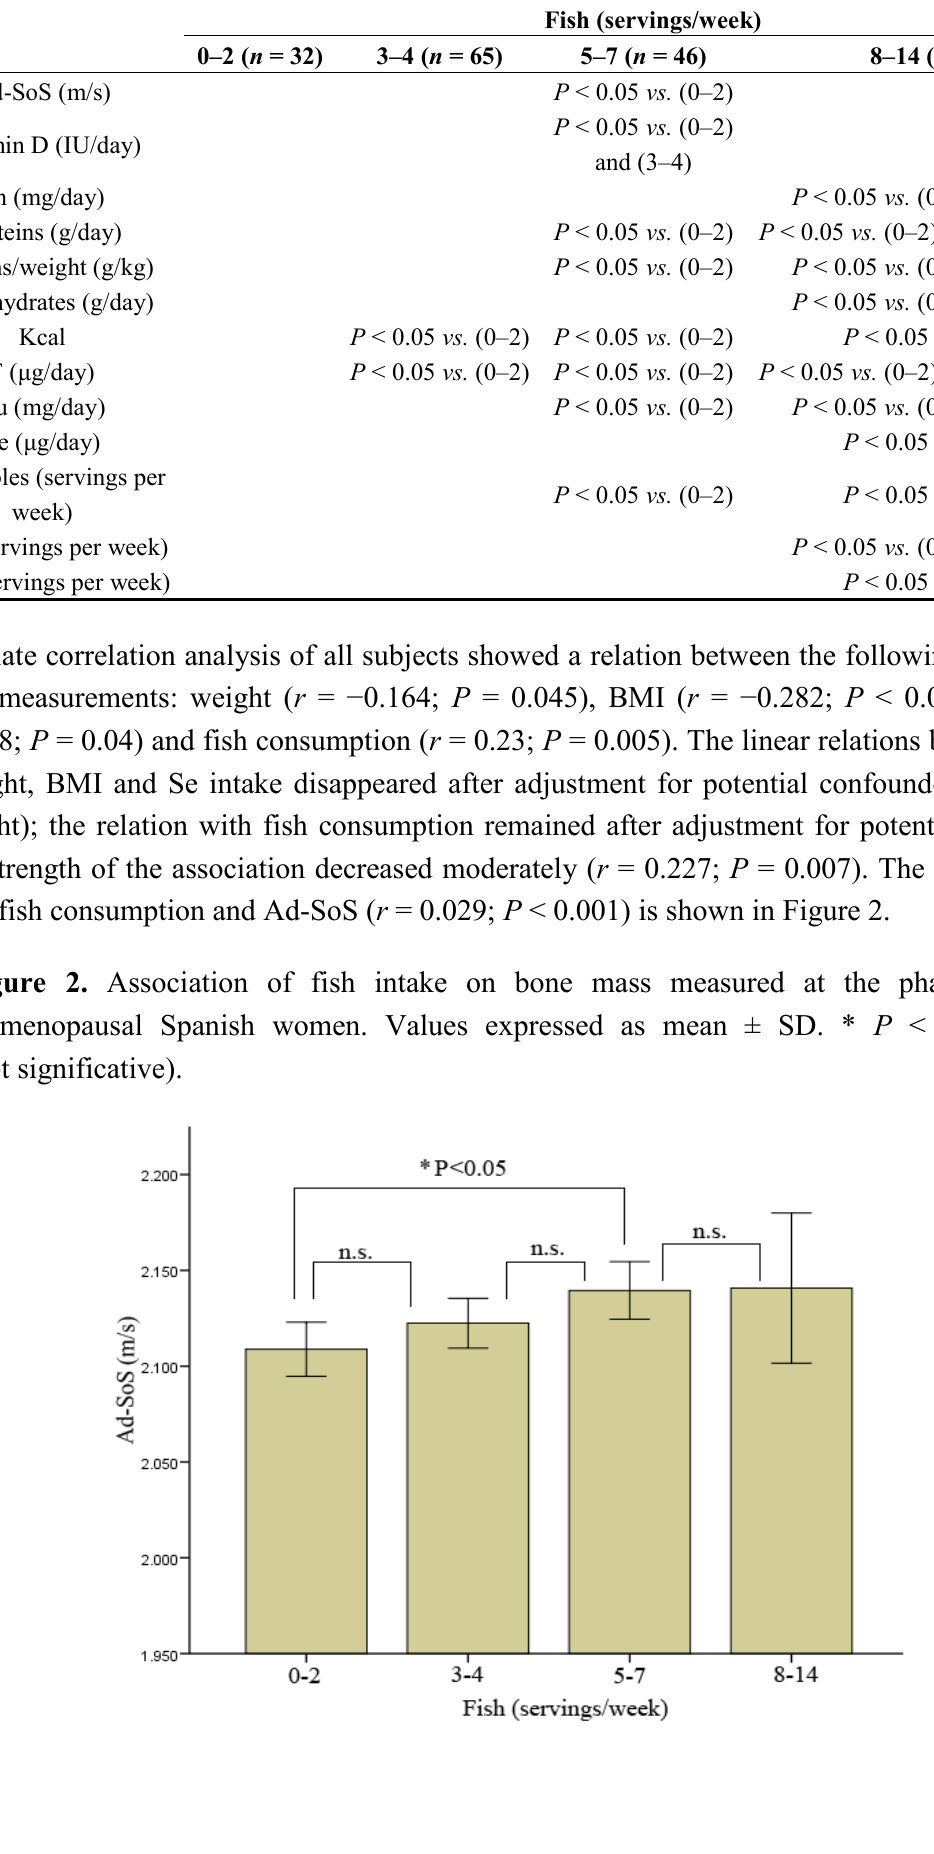
Table 5. Fish consumption and significance levels of comparisons between groups.